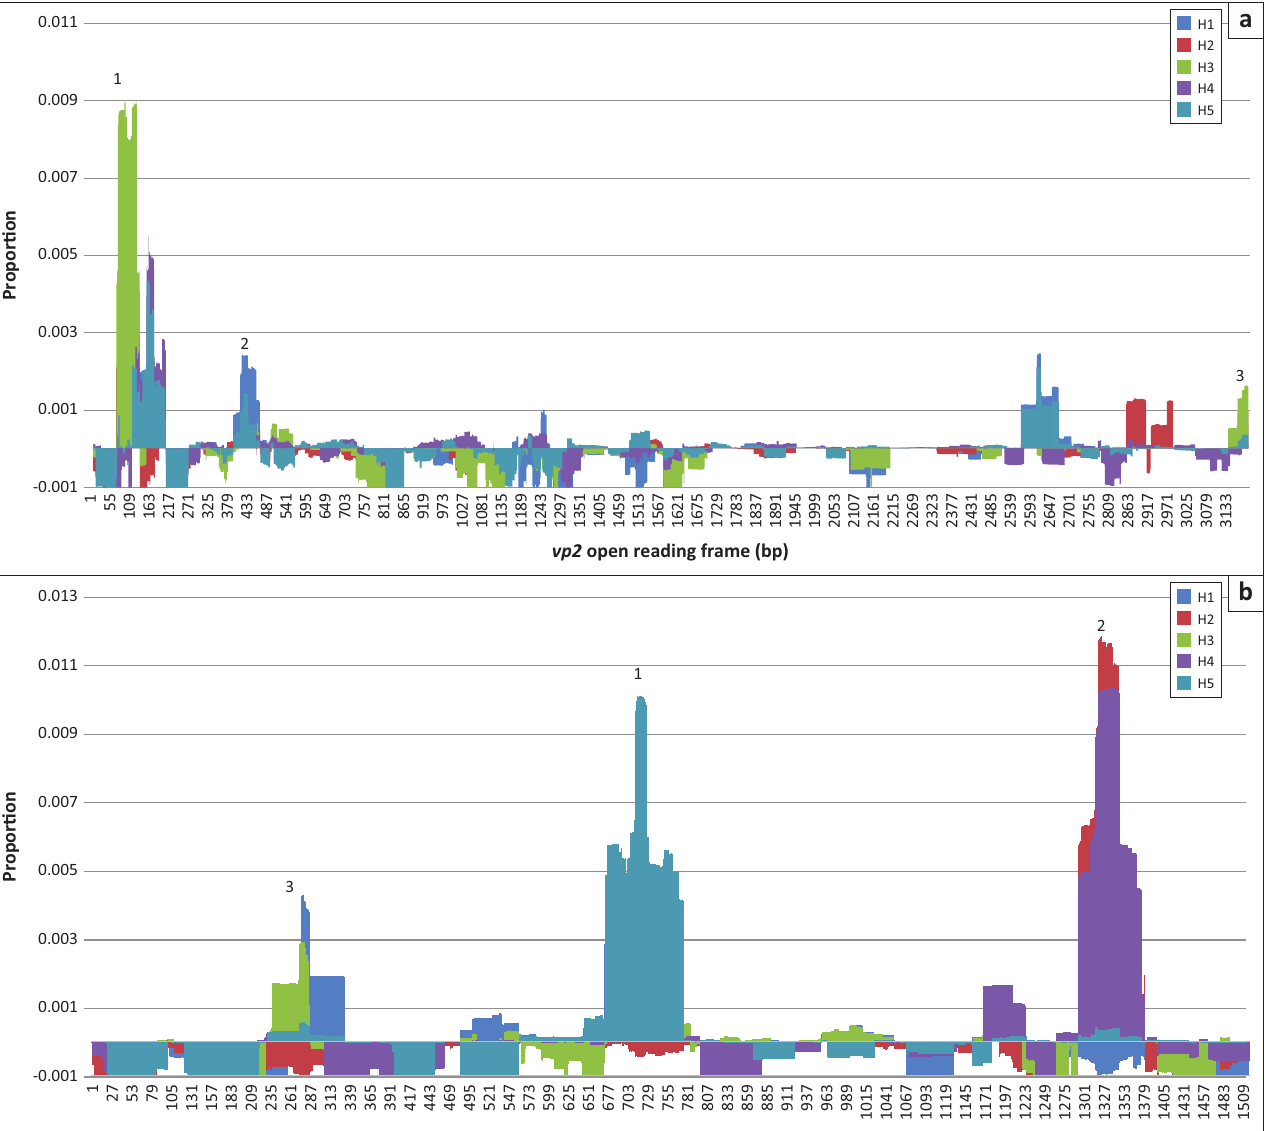
FIGURE 5: Day 28 IgG-selected VP2 (a) and VP5 (b) sequences, of all five horses, converted to matches per nucleotide position as a proportion of the total nucleotide matches per gene segment. Numbers represent the identified potentially antigenic regions. Data were normalised by subtraction of day 0